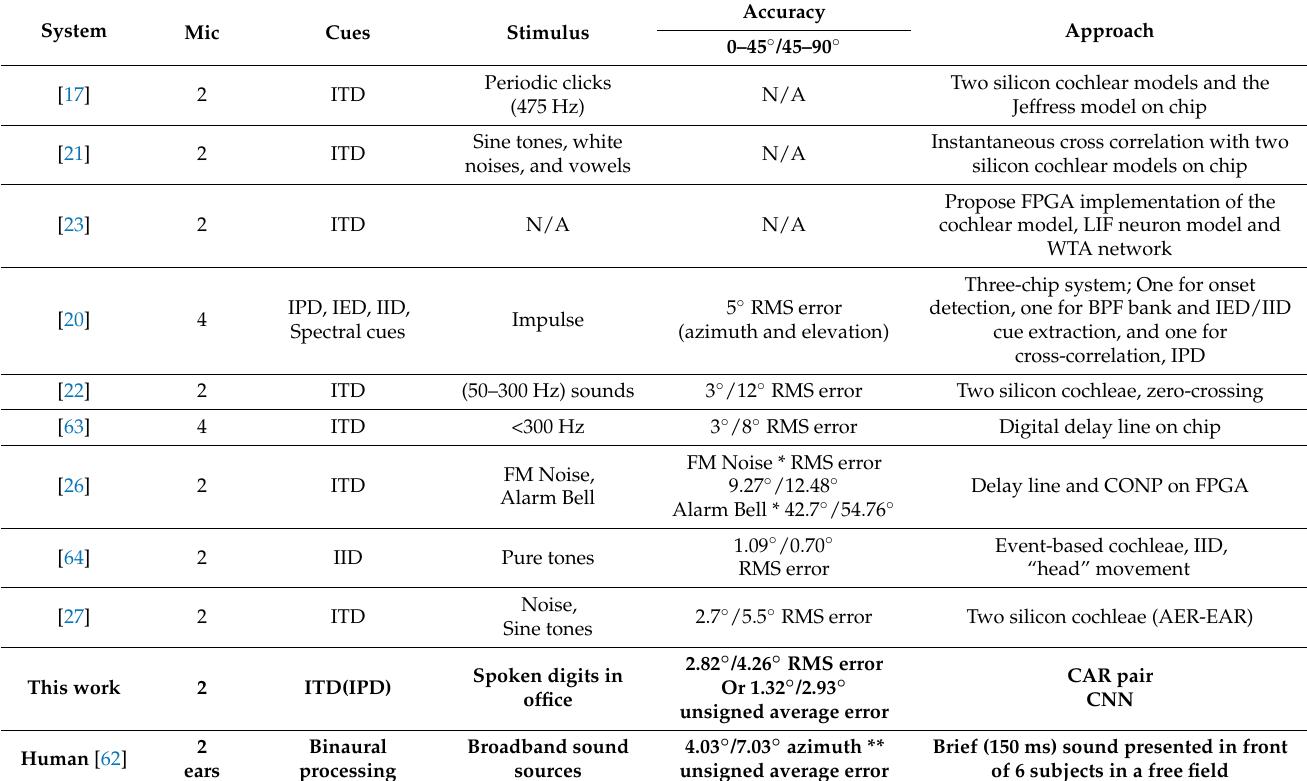
Figure 10. CNN results with different CAR configurations and different quantised correlogram inputs. Table 4. Comparisons of sound localisation systems.